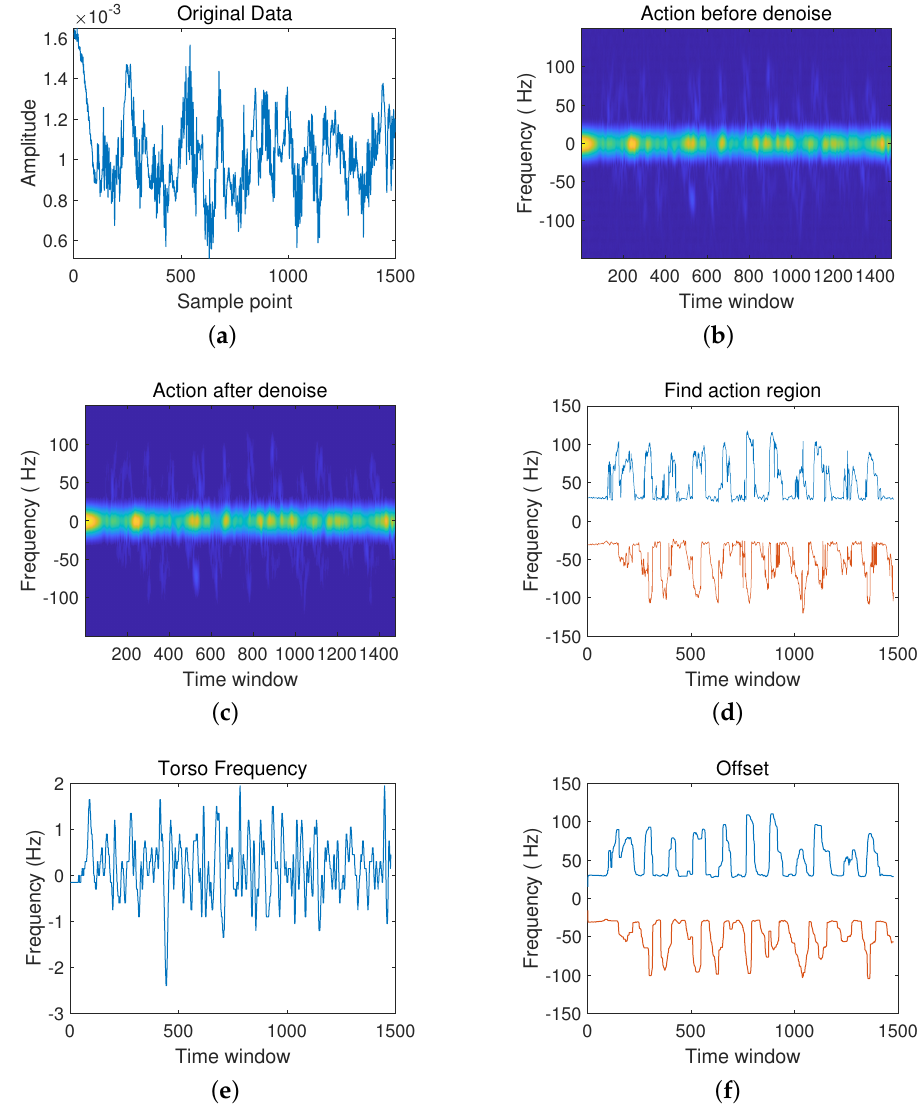
Figure 11. Schematic Diagram in boxing. ( a ) The original data; ( b ) Frequency Spectrum Diagram Before Noise Reduction; ( c ) Frequency spectrum diagram after noise reduction; ( d ) Action interval; ( e ) Body frequency; ( f )